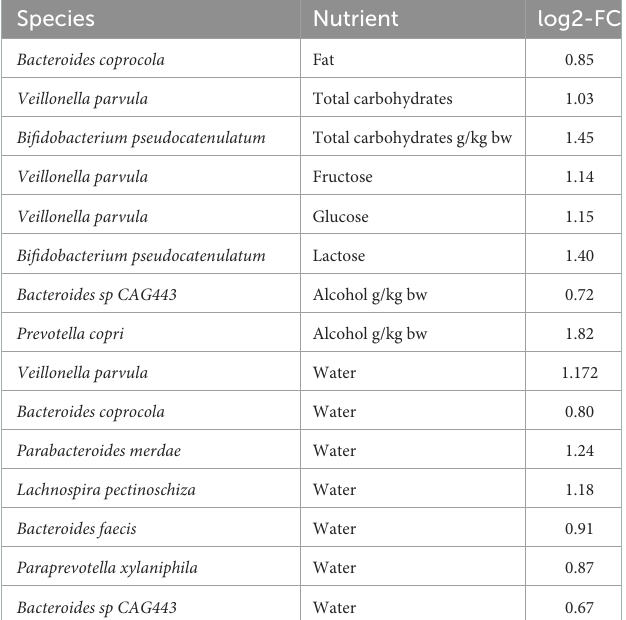
TABLE 4 Bacterial species associated with nutrient parameters, as signified by the LINDA